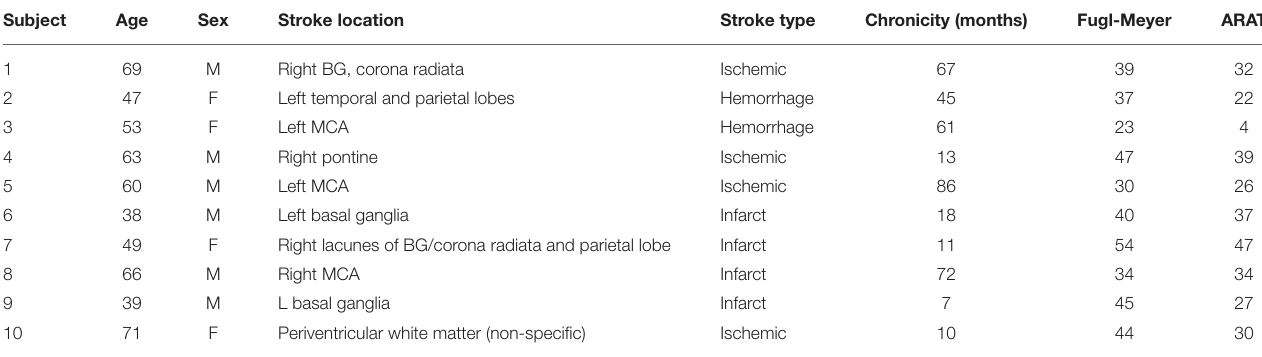
TABLE 2 | Participant characteristics.